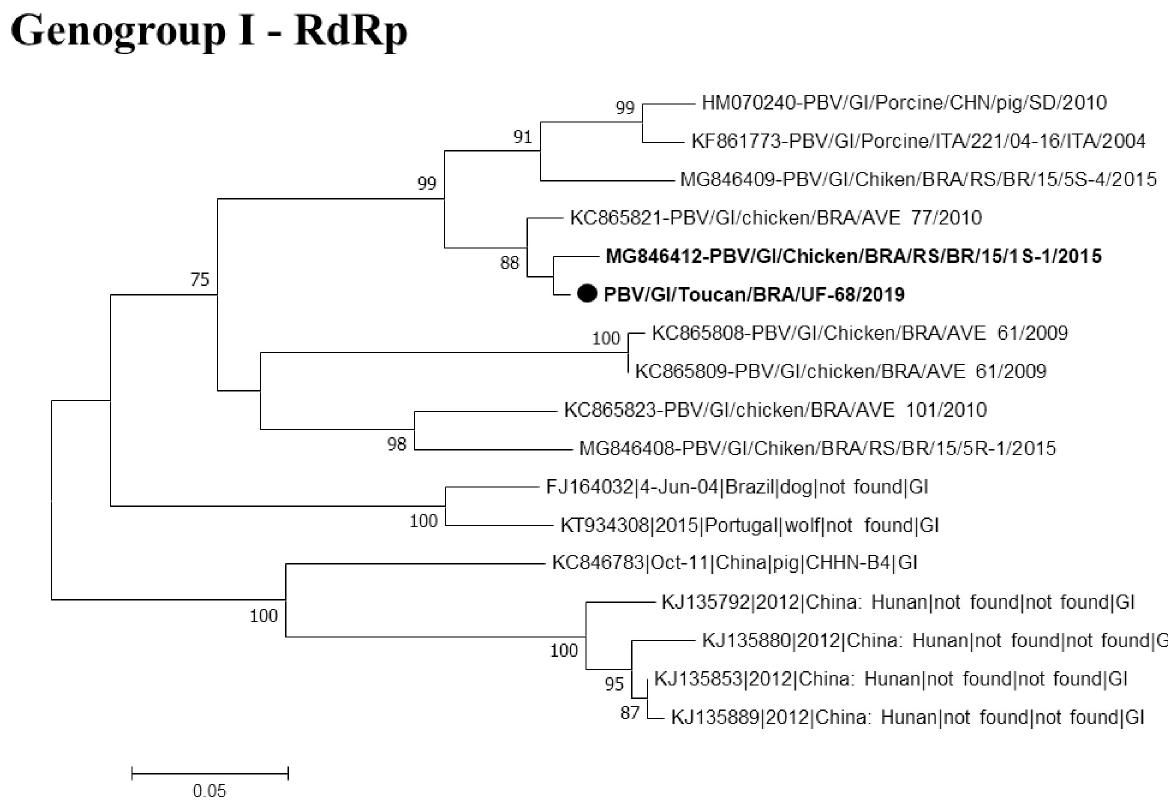
Fig 7. Phylogenetic tree based on sequence alignment of the PBV RdRp gene. The sequence of this study is represents in bold, and the black color depicts the birds. The numbers next to the nodes indicate bootstrap values > 70.